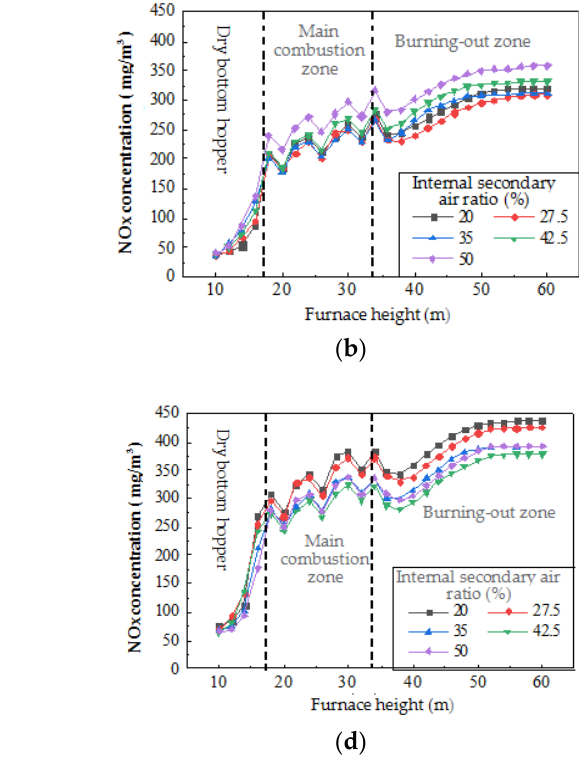
Figure 17. Variation in NOx concentration along the furnace height under different internal secondary air ratio: ( a ) Variation in NOx concentration along the furnace height under different internal secondary air ratio and 600 MW boiler load; ( b ) Variation in NOx concentration along the furnace height under different internal secondary air ratio and 500 MW boiler load; ( c ) Variation in NOx concentration along the furnace height under different internal secondary air ratio and 400 MW boiler load; ( d ) Variation in NOx concentration along the furnace height under different internal secondary air ratio and 250 MW boiler load.